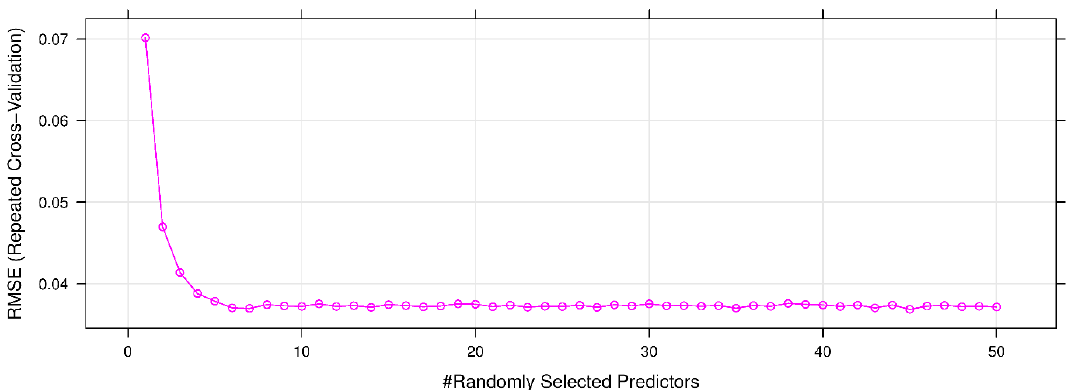
Figure 8. Performance of the random forest (RF) model for forecasting PM 10 concentration on the training dataset.